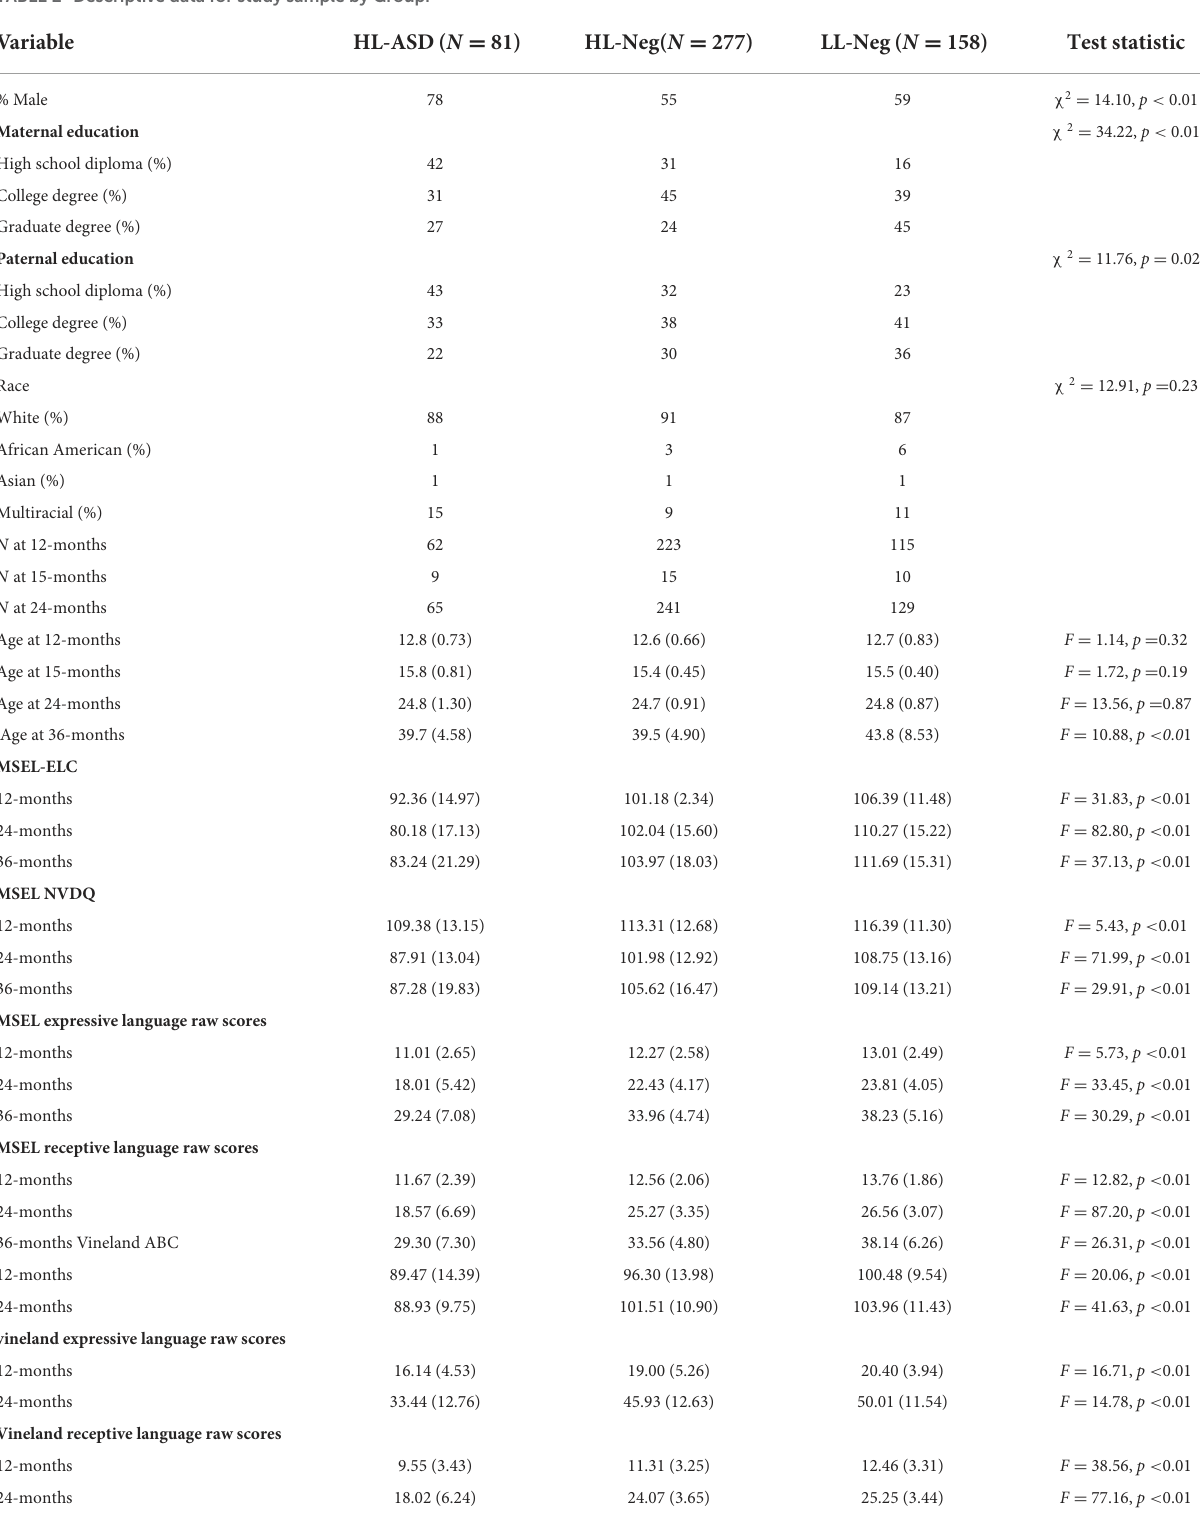
TABLE 2 Descriptive data for study sample by